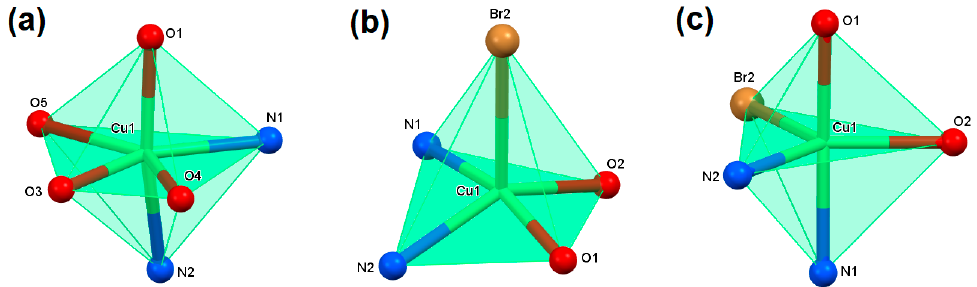
Figure 2. Coordination polyhedra of the compound 1 ( a ) and 2 ( b – c ). For a description, see the text. Table 1. Selected structural data of the studied compounds.